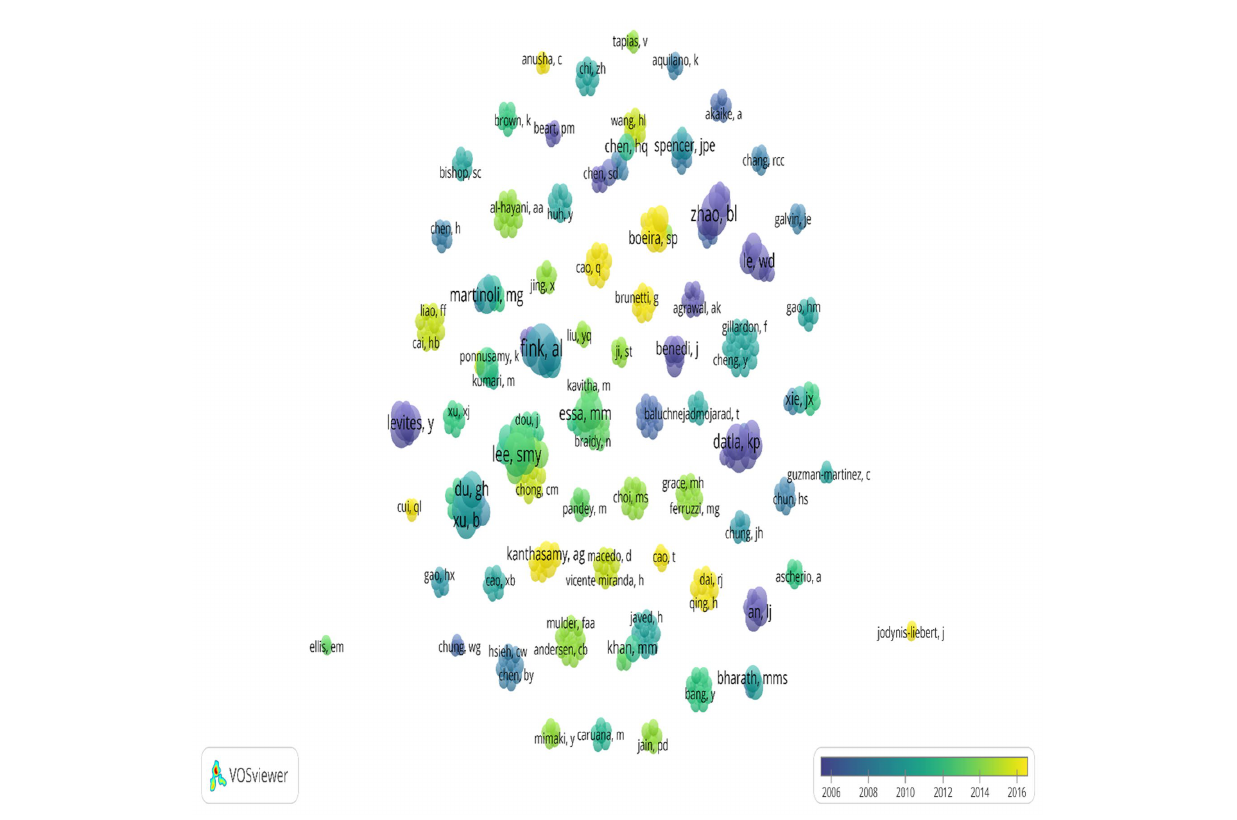
FIGURE 2 VOSviewer co-authorship map demonstrating the bibliographic coupling between the 497 authors of the 100 most cited articles on PD and PCs. The authors form 66 clusters. The cluster size represents the frequency of publications. The color scale represents the period in which the publications occurred. Overlapping nodes does not allow viewing the name of all authors who contributed to the 100 most cited articles. Authors with the highest number of publications are superimposed on authors with the lowest number of